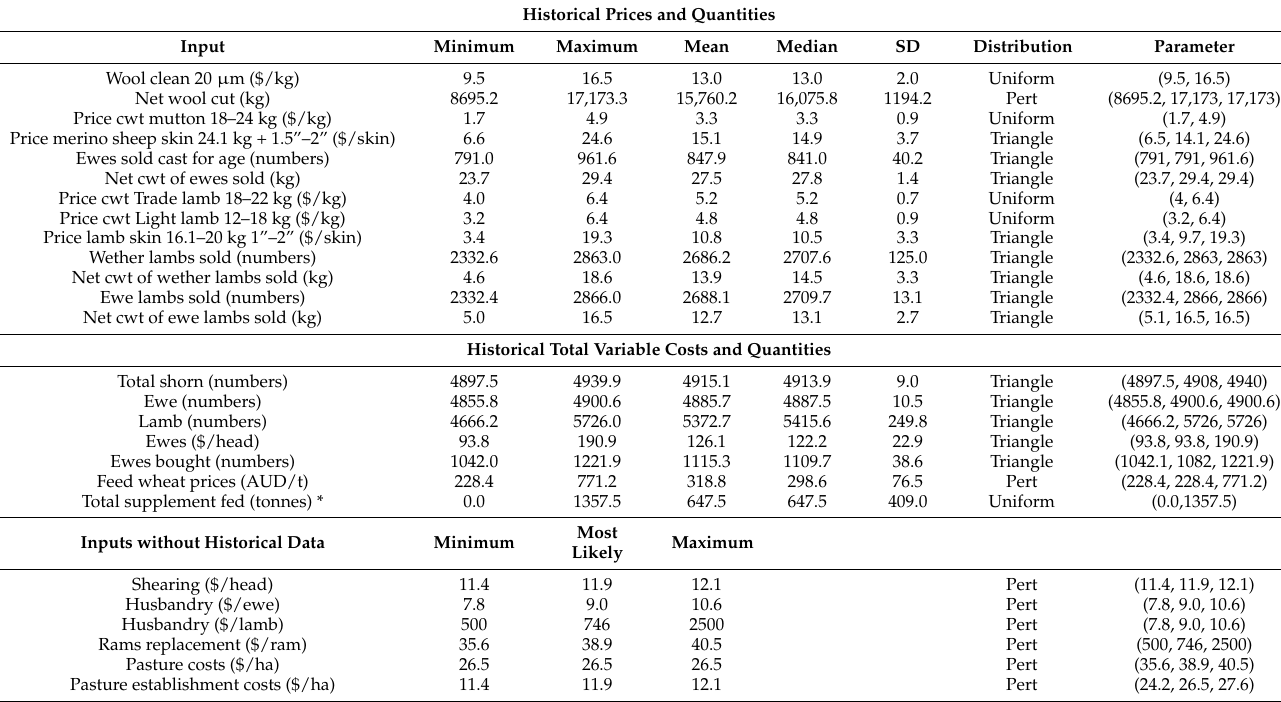
Table 2. Fitted distributions of historical prices, total variable costs and quantities (and their theoretical summary statistics) for the 1000 ha merino ewe and first-cross lamb enterprise.